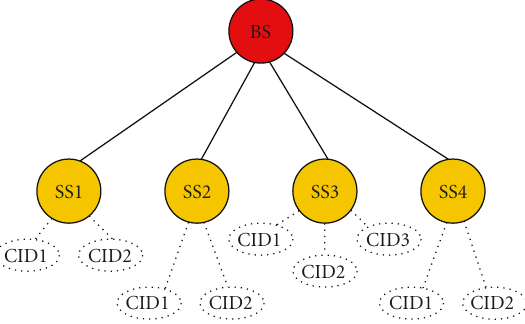
Figure 5: Setup of the network under test.